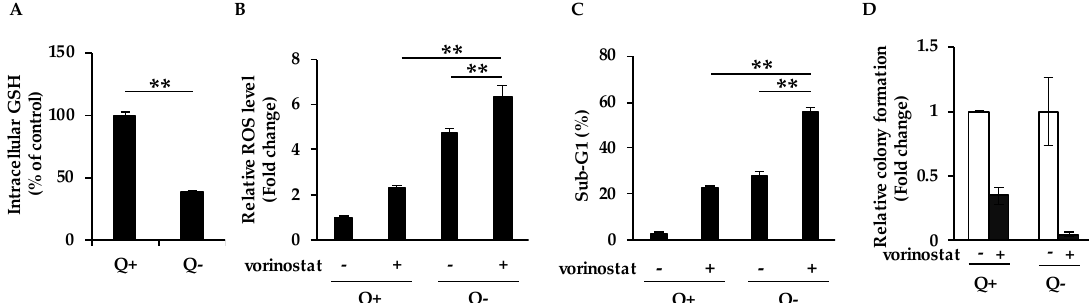
Figure 1. Glutamine deprivation increases sensitivity to vorinostat. ( A ) Measurement of intracellular glutathione (GSH) levels in media with / without glutamine. MDA-MB-231 cells were cultured in the presence of 4 mM glutamine (Q + ) or in the absence of glutamine (Q − ) for 24 h and subjected to the intracellular GSH content assay. The data obtained with complete media were taken as 100%. Columns, means ( n = 3); bars, SD. ** p < 0.01. ( B ) Flow cytometry analysis of ROS levels in cells treated with vorinostat in media with / without glutamine. MDA-MB-231 cells were cultured in the presence of 4 mM glutamine (Q + ) or in the absence of glutamine (Q − ) for 24 h, and then treated with 1.6 µ M vorinostat for 48 h. The amount of ROS in cells was detected by CM-H2DCFDA using a flow cytometer. The data obtained with dimethyl sulfoxide (DMSO) control in complete media were taken as 1. Columns, means ( n = 3); bars, SD. ** p < 0.01. ( C ) Flow cytometry analysis of cell death after vorinostat treatment in media with / without glutamine. MDA-MB-231 cells were cultured in the presence of 4 mM glutamine (Q + ) or in the absence of glutamine (Q − ) for 24 h, and then treated with 1.6 µ M vorinostat for 144 h. The percentages of cells in the sub-G1 population were analyzed by flow cytometry. Columns, means ( n = 3); bars, SD. ** p < 0.01. ( D ) The colony formation of cells treated with vorinostat in media with / without glutamine. MDA-MB-231 cells were cultured in the presence of 4 mM glutamine (Q + ) or in the absence of glutamine (Q − ) for 24 h, and then treated with 1.6 µ M vorinostat for 144 h. Colony formation was quantified using ImageJ. The data obtained with DMSO control in each condition were taken as 1. Columns, means ( n = 3); bars,